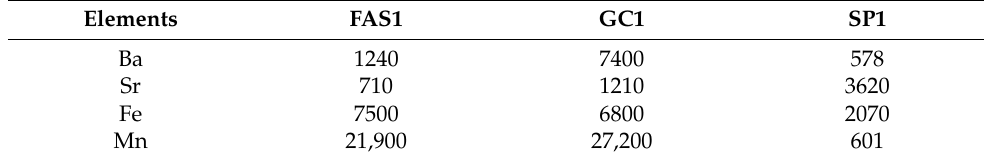
Table 4. Minor elements (mg/kg) of the studied samples from ICP-AES analyses.